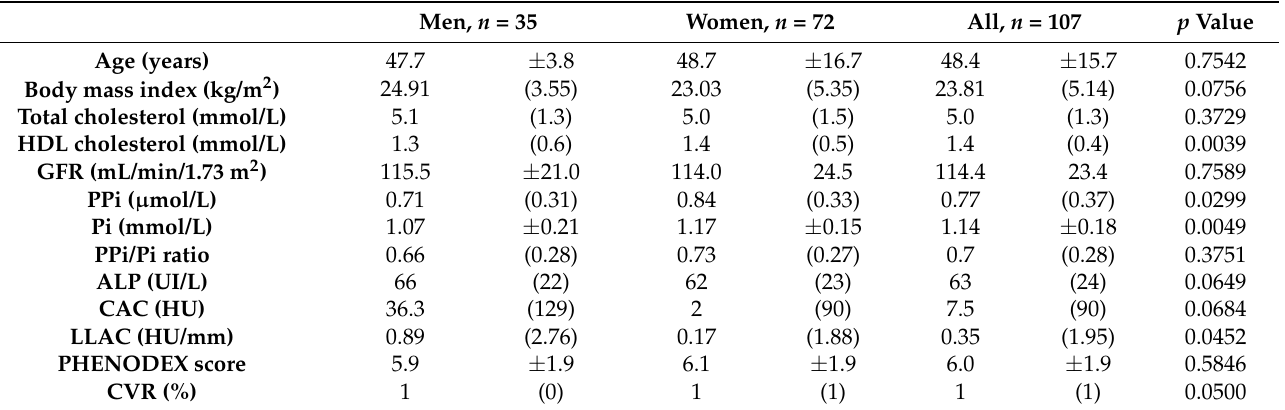
Table 1. Summary of biometric and biological variables. Comparisons between men and women PXE patients is shown. Data with a normal distribution are expressed as mean ( ± SD), others are expressed as median (interquartiles). PPi: inorganic pyrophosphate; Pi inorganic phosphate; ALP: alkalin phosphatase; GFR: glomerular filtration rate; CAC: Coronary arterial calcification; LLAC: Lower limb arterial calcification; CVR: 10 years—Cardiovascular Risk score. Men, n = 35 Women, n = 72 All, n = 107 p